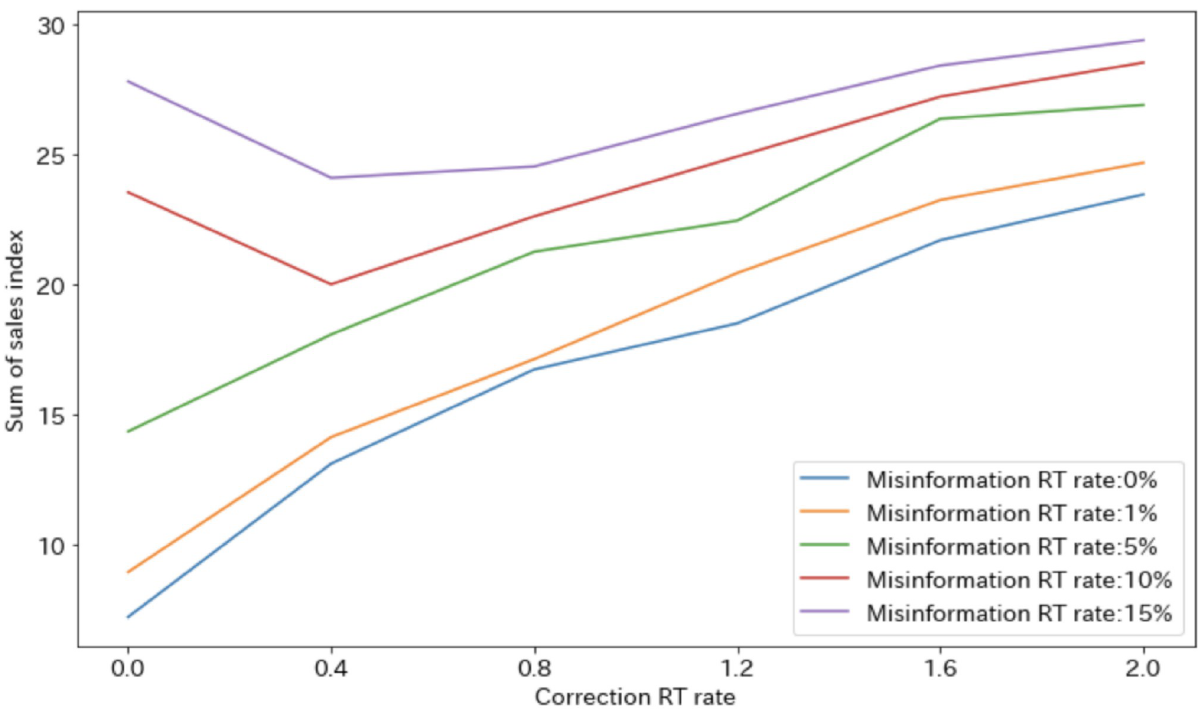
Fig 6. Results of optimal diffusion rate estimation